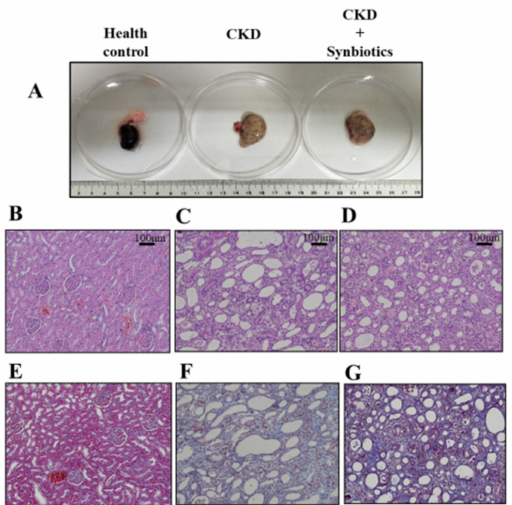
Figure 7. The kidney pathology in the controls, CKD rats, and synbiotics-treated CKD rats. ( A ) The gross examination of the kidney. ( B – D ) Hematoxylin and eosin stains of rat kidney tissues in control ( B ), CKD ( C ), and synbiotics-treated CKD ( D ). ( E – G ) Masson’s trichrome stains of rat tissues in control ( E ), CKD ( F ), and synbiotics-treated CKD ( G ). n = 6 for each group.